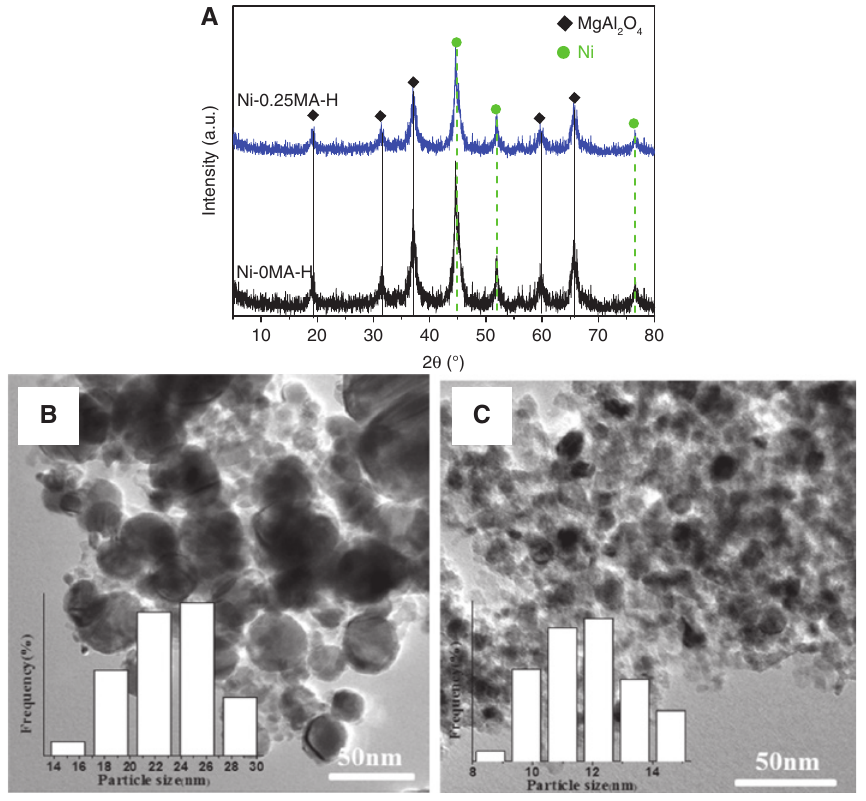
Figure 8: XRD patterns (A) and TEM image of the hydrothermally treated catalysts: (B) Ni-0MA-H and (C)